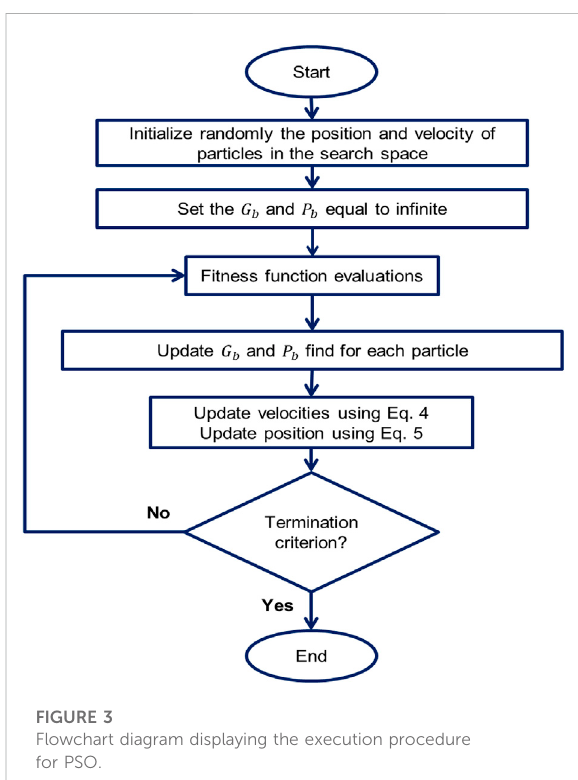
FIGURE 3 Flowchart diagram displaying the execution procedure for PSO.